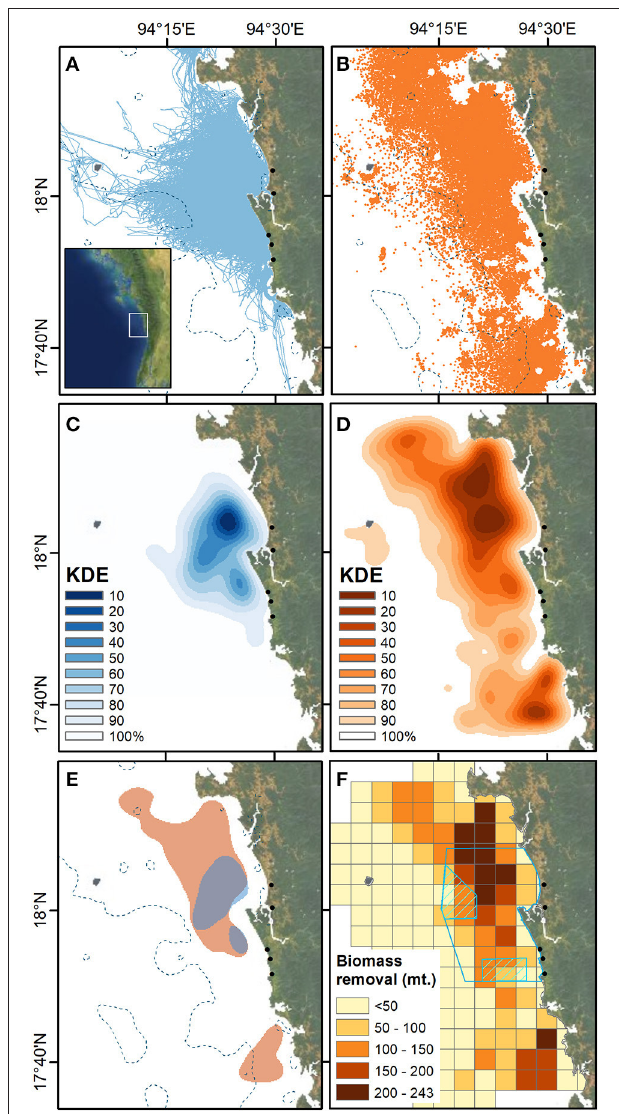
FIGURE 4 | Kernel density estimation (KDE) analysis and spatial biomass removal. (A) The unprocessed GPS vessel tracks. (B) The raw VBD data (October to May 2016–2019). (C) KDE of processed GPS tracks using a 250 × 250m grid cell and a 5km search radius. (D) KDE of processed VBD data using a 250 × 250m grid cell and a 5km search radius. (E) Core activity areas of each dataset using the 50th percentile of the data. (F) Annual biomass removal estimate using a cumulative sum of monthly estimates at a 5 × 5km grid cell resolution, with KIFCA boundaries and zonal gear restrictions (mesh size > 1.5cm) (blue hash). Key landing sites identified in Figure 1 shown (black